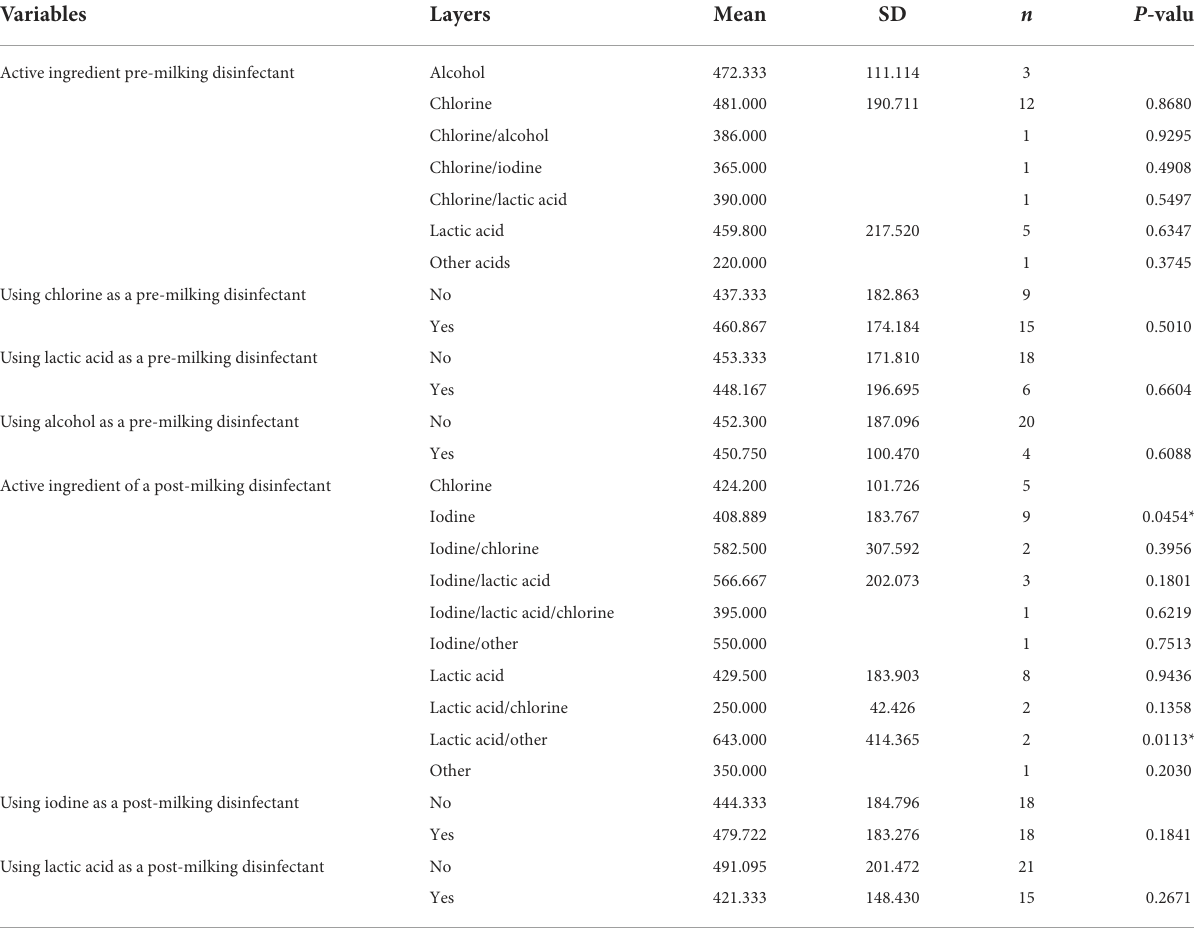
TABLE 3 Relationships between somatic cell count (SCC/ml) and pre- and post-milking disinfectants. Variables Layers Mean SD n P